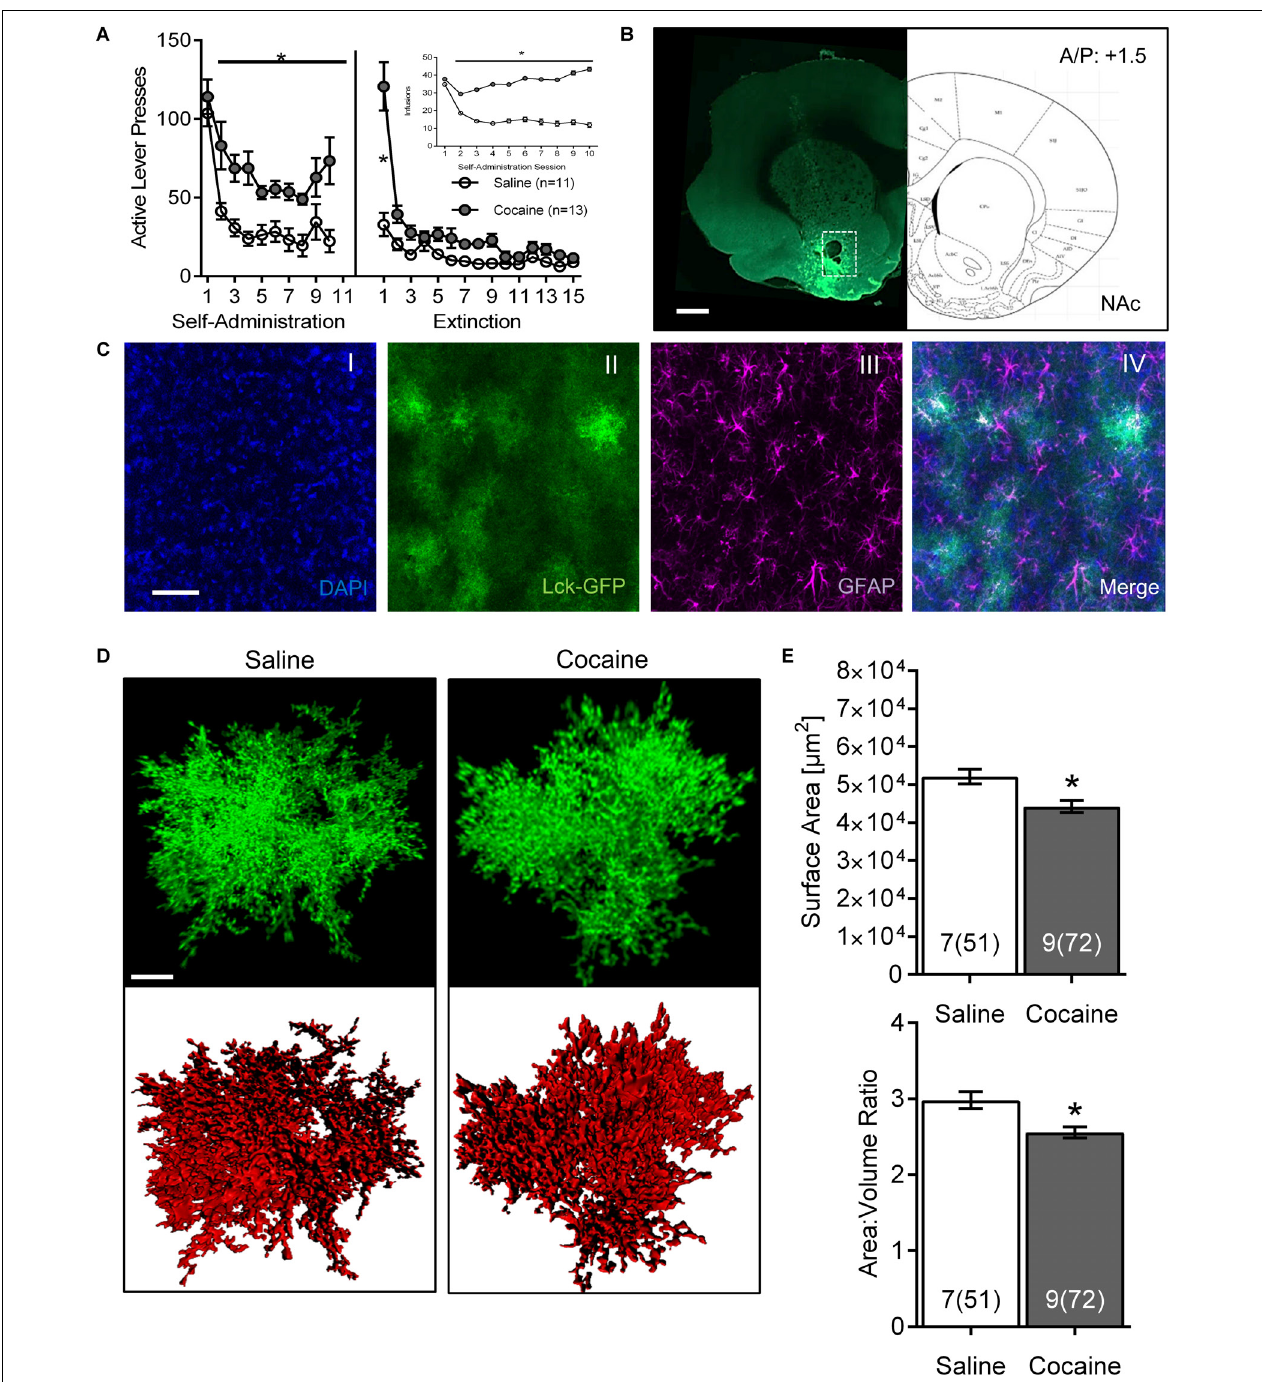
FIGURE 1 | Cocaine self-administration and extinction reduces astrocyte surface area and surface area:volume ratio in the NAc core. (A) Active lever presses by session across self-administration (10 days) and extinction (15 days) training. Insert: number of infusions during self-administration sessions ( ∗ p < 0.05 by two-way ANOVA). (B) Scan of a brain slice showing the intensity and the range of expression of the AAV5 GfaABC1D-Lck-GFP. The white dotted box shows the area of NAc from which astrocytes were selected for imaging. 10 × magnification, scale bar: 1 mm. (C) Multiple intensity projection (MIP) of an area within the NAc showing Lck-GFP expressing astrocytes (II) as well as staining for DAPI (I), GFAP (III), and merged image (IV). Colocalization between GFAP and Lck-GFAP is shown in white. 20 × magnification, scale bar: 50 µ m. (D) Representative isolated astrocytes from saline and cocaine-experienced rats imaged in the NAc. Lck-GFAP signal is shown in green and surface rendering used for volumetric measurements in red. 63 × magnification, scale bar: 10 µ m. (E) Astrocyte surface area and surface area:volume ratio in NAc are significantly decreased in cocaine-administering rats compared to saline-administering rats. Bar insert: number of animals and number of cells (in parentheses). ∗ p < 0.05 by nested